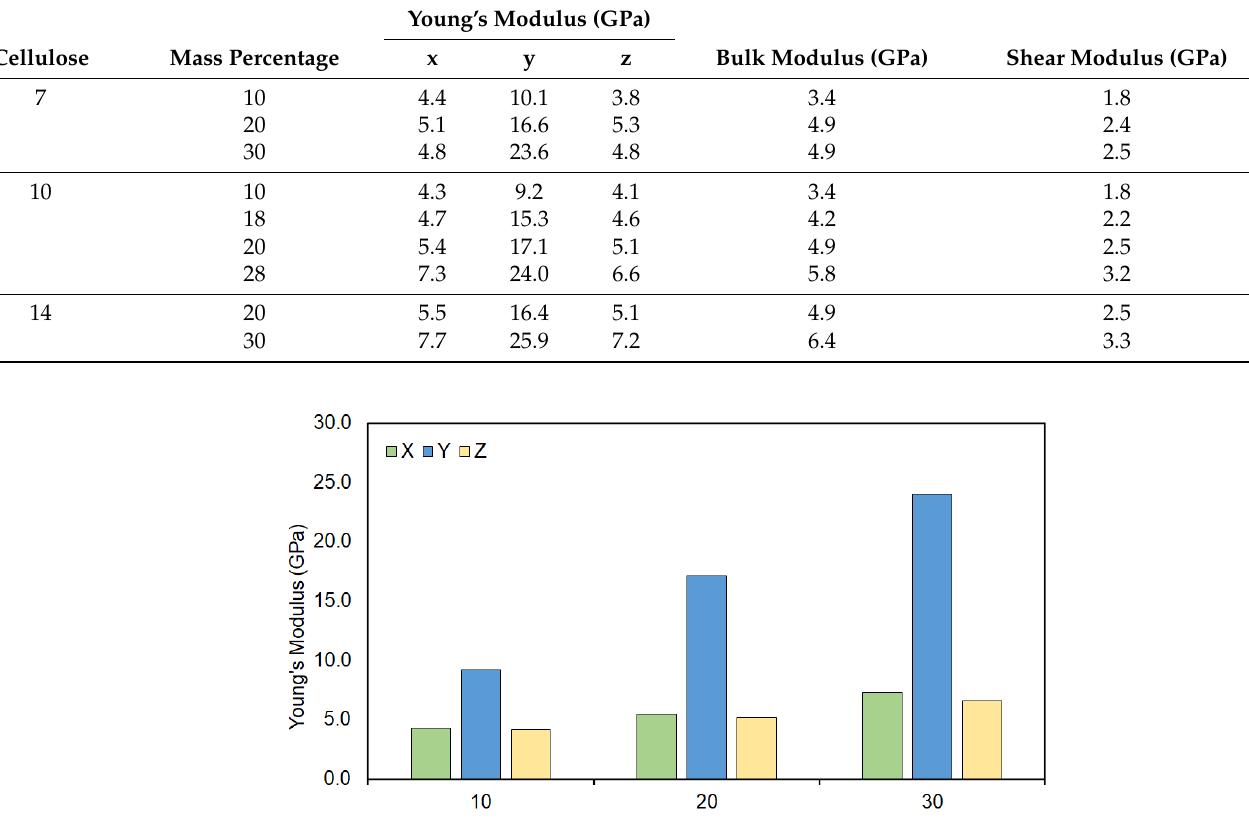
Table 2. Simulated mechanical properties of cellulose–PP composite using different amounts of cellulose chains in fibril and different mass percentages of cellulose. PP chains had 50 monomers in them.